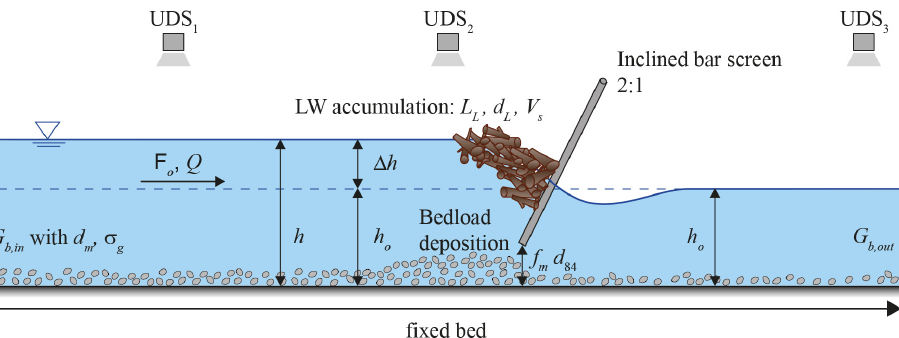
Figure 1. Test setup and notation with Froude number F o [-], discharge Q [l/s], approach flow depth h o [cm], resulting water depth with wood blockage h [cm], backwater rise ∆ h [cm], and bottom clearance height f m d 84 [mm]. Ultrasonic distance sensors (UDS) to measure h . LW accumulation with log length L L [cm], log diameter d L [cm], and solid wood volume V s [m 3 ]. Bedload transport input rate G b , in [g/s] and output rate G b , out [g/s] with mean sediment diameter d m [mm] and sorting coefficient of the grain size distribution σ g [-]. Potential bedload deposition is illustrated upstream of the inclined bar